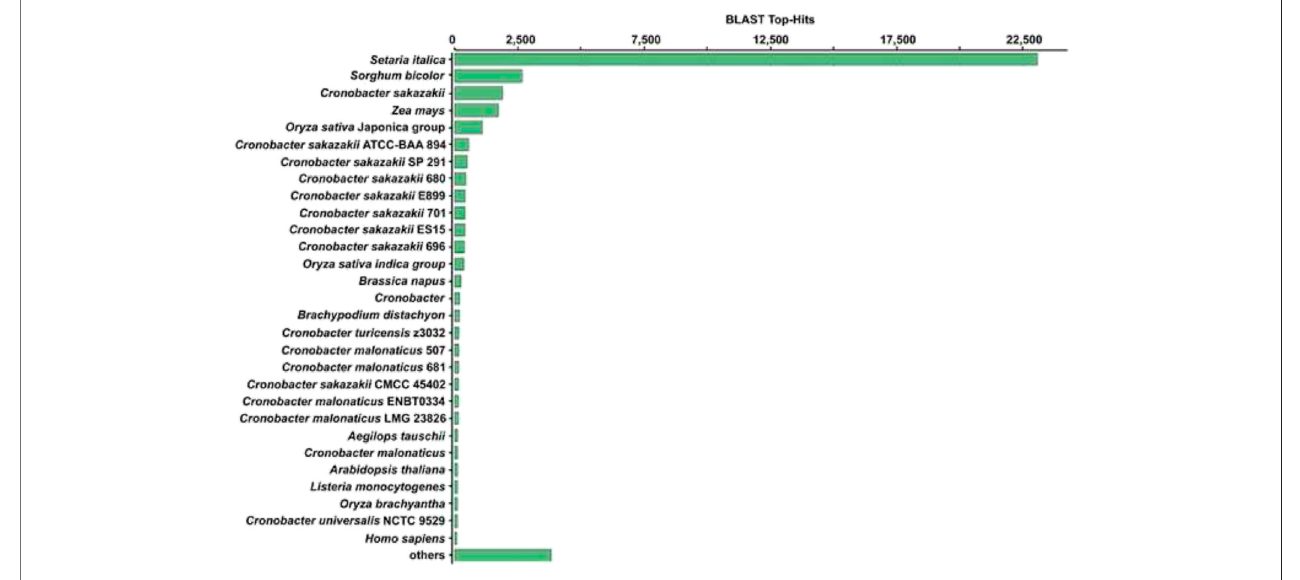
FIGURE 2 | Distribution of the top BLAST hits in different